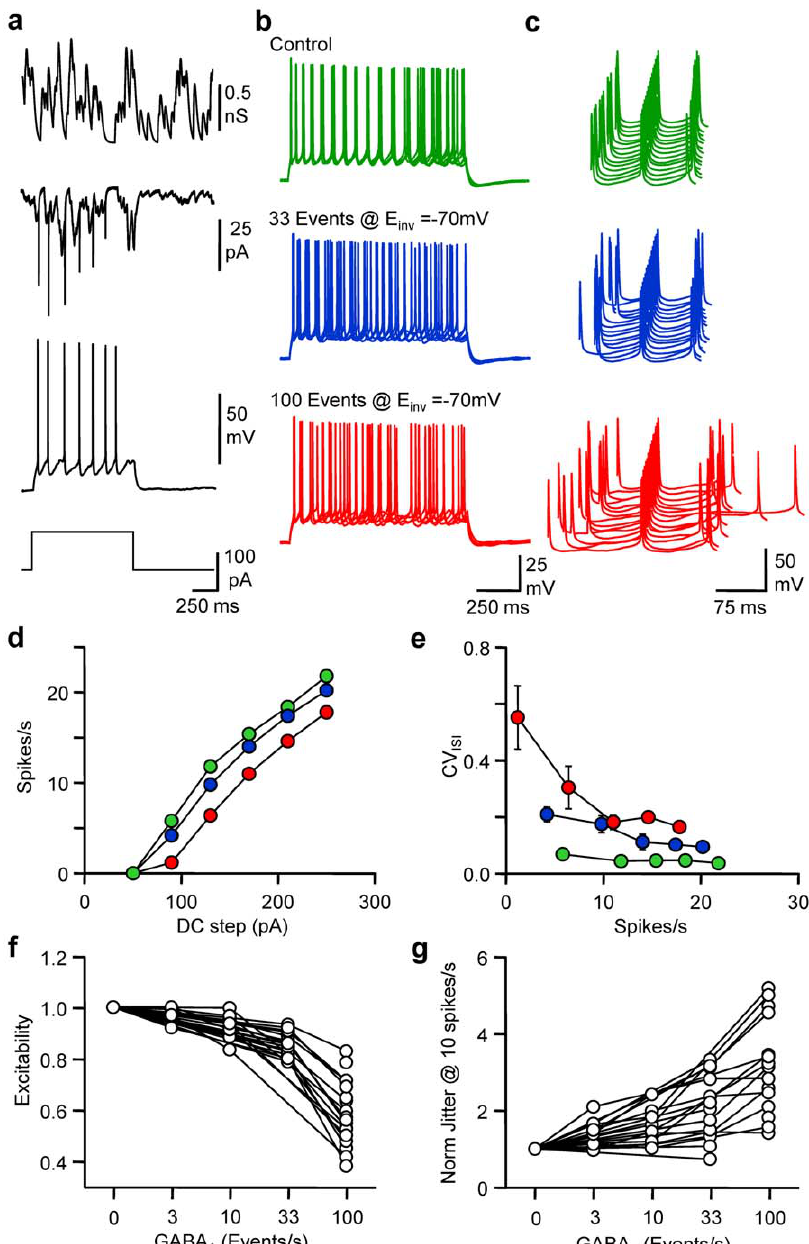
Figure 2. Frequency-dependent tuning of pyramidal cell excitability and spike timing. a, From upper to lower, an example of a GABA A conductance (G GABA-A ) pattern of 33 events/s, GABA A current (I GABA-A ), Vm and the DC protocol in a dynamic clamp recording of a L2/3 pyramidal cell. b, Superimposed (5) Vm fluctuations in response to a DC step (1 s, 170 pA) in control (green), in the presence of 33 (blue) or 100 (red) randomly occurring GABA A events/s dynamically injected with E GABA set at 2 70 mV. Same cell and colour code for c,d and e. c, Waterfall view of Vm when the 5 th spike was set as the time reference. d, Mean Firing rate vs DC step. e, CV ISI vs mean spike firing rate. f, Normalised changes in excitability observed when neurons receive different levels of randomly occurring GABA A events/s. g, Normalised changes in spike jitter for an interpolated firing rate of 10 spikes/s.